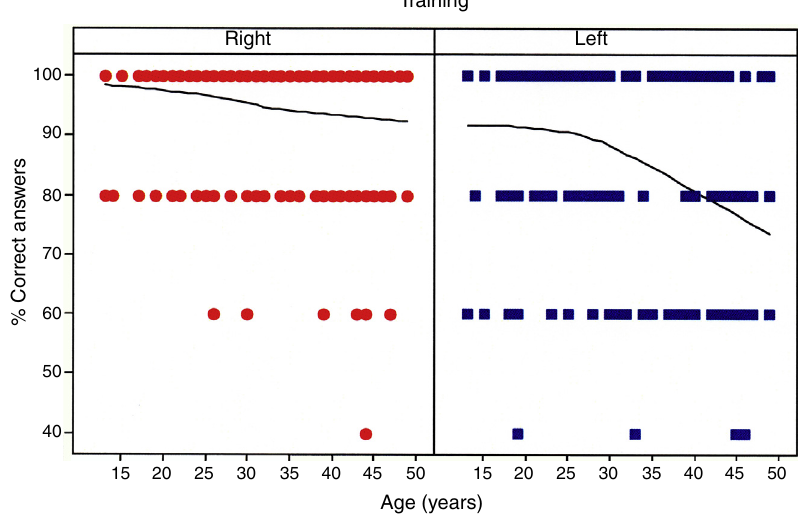
Figure 1 Scatter plots of correct answer percentages in the training stage by age and ear.